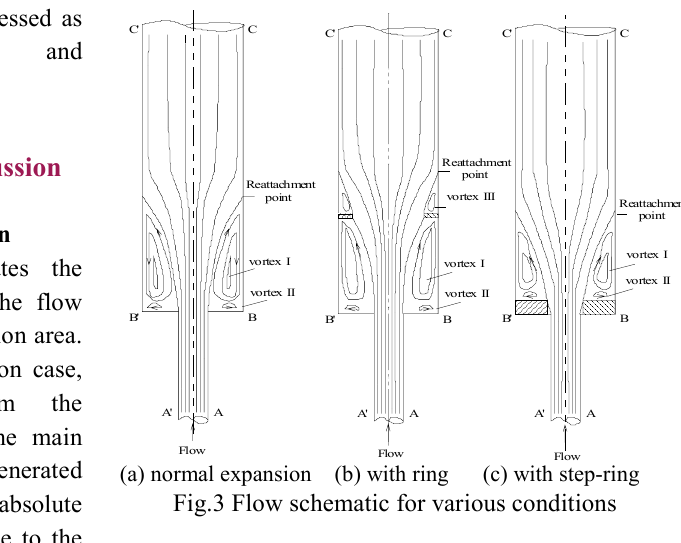
Fig.3 Flow schematic for various conditions